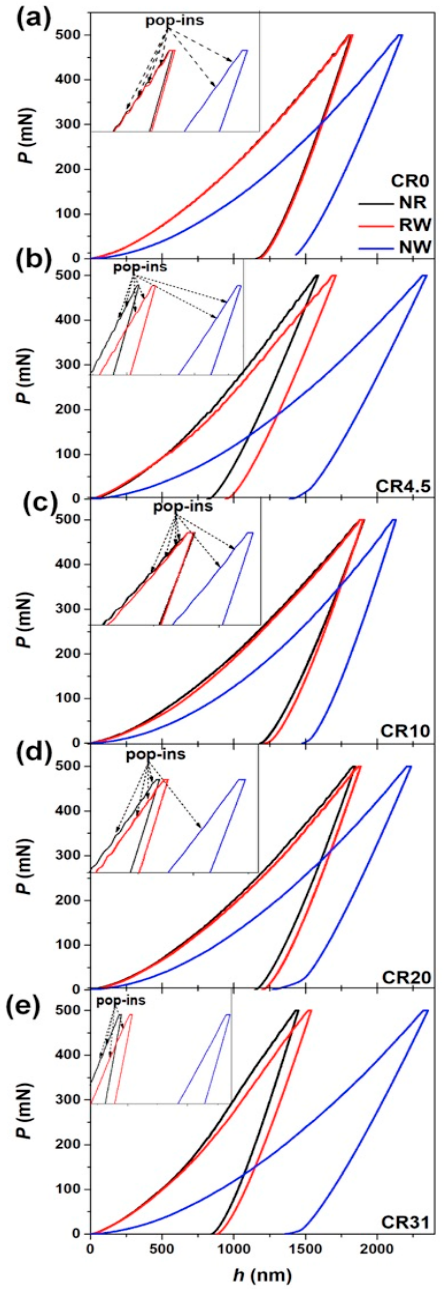
Figure 6. P - h plots at P max = 500 mN for NR, RW, and NW planes: ( a ) CR0, ( b ) CR4.5, ( c ) CR10, ( d ) CR20, and ( e ) CR31; pop-in events are more pronounced in CR0, which gradually decreases with the increase of cold rolling percentage.